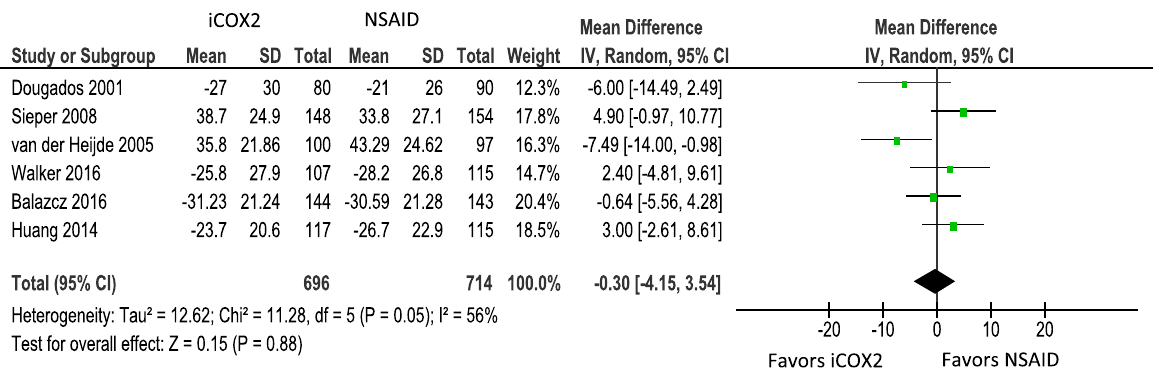
Fig. 3 Spinal pain by visual analog scale (VAS 0 – 100mm) comparing traditional NSAIDs versus iCOX2 in patients with ankylosing spondylitis: meta-analysis of six randomized clinical trials. Subtitle: (1) Celecoxib 200mg vs ketoprofen 200mg. (2) Celecoxib 400mg vs diclofenac 75mg. (3) Etoricoxib 90mg vs naproxen 1000mg. (4) Celecoxib 200mg vs diclofenac 50mg. (5) Etoricoxib 90mg vs naproxen 1000mg. (6) Celecoxib 200mg vs diclofenac